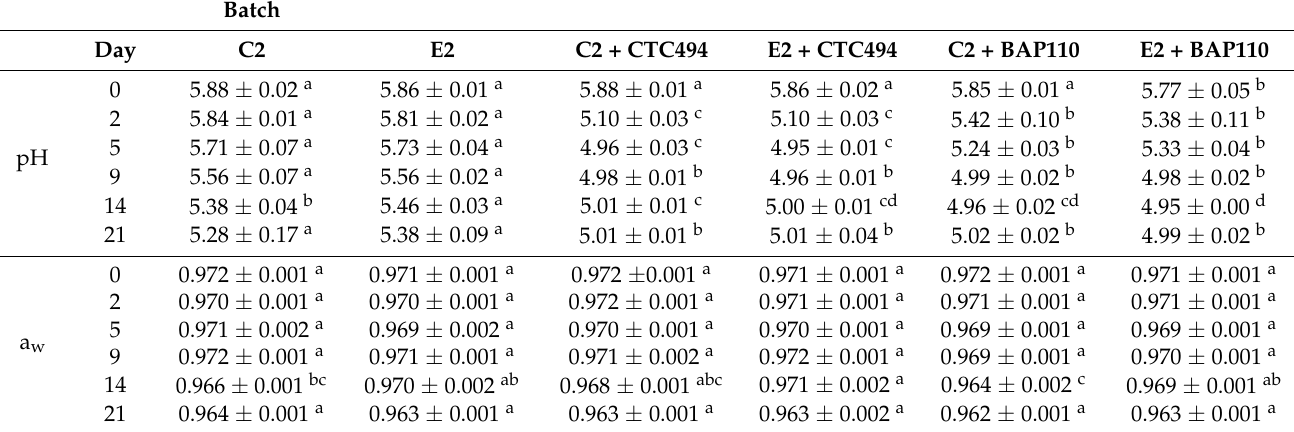
Values are mean ± standard deviation of triplicates. For each sampling day, significant differences between batches are indicated by different superscript letters ( p <